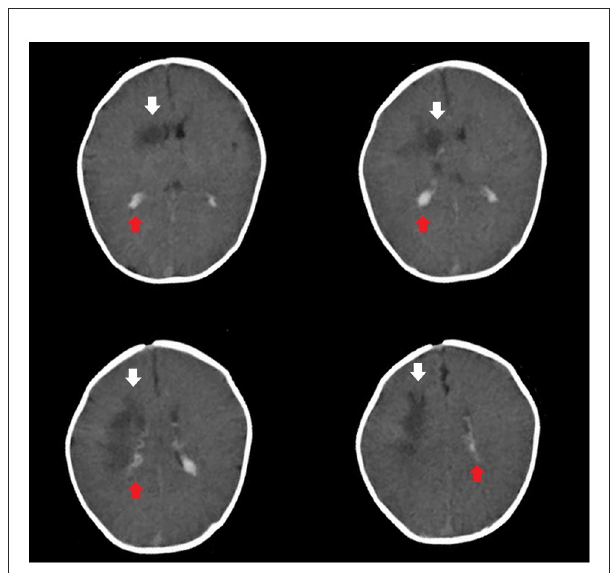
FIGURE1 Brain computed tomography revealed subarachnoid hemorrhage (the red arrow) and irregular hypointensity shadows beside the right lateral ventricle (the white arrow).